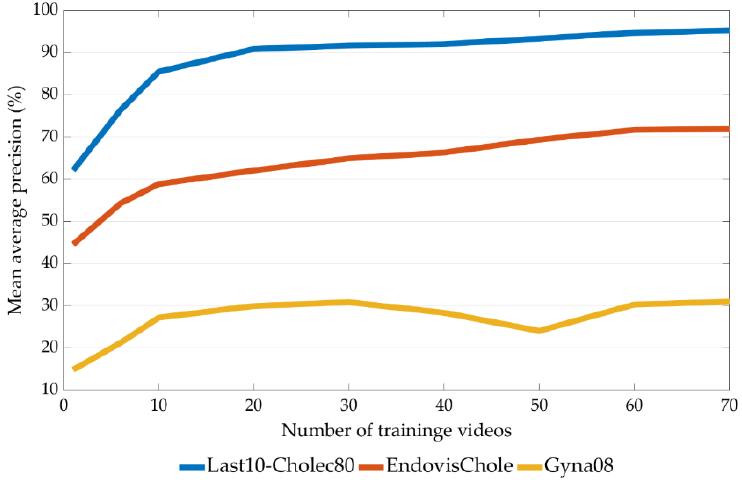
Figure 9. Mean average precision on the tools in the last ten videos of the Cholec80, EndovisChole and Gyna08 datasets as a function of training set size.